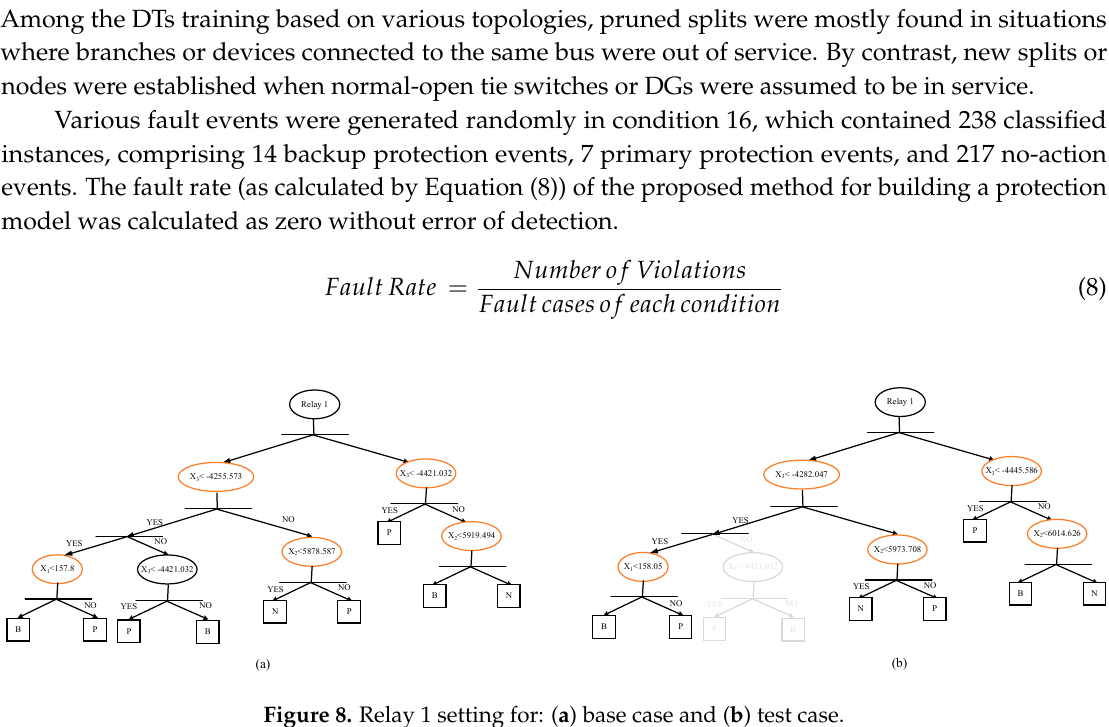
Table 2. Sixteen conditions considered for system tests.